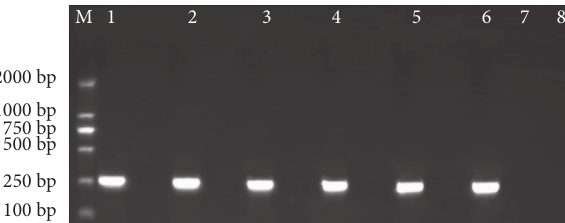
Figure 7: The PCR analysis of the short-term test of genomic DNA reference materials for 14 days. M , DNA marker D (100 ∼ 2000bp); lanes 1–3, PCR results of 3 samples stored at 4 ° C, respectively; lanes 4–6, PCR results of 3 samples stored at 37 ° C, respectively; lane 7, negative control; and lane 8, blank control.